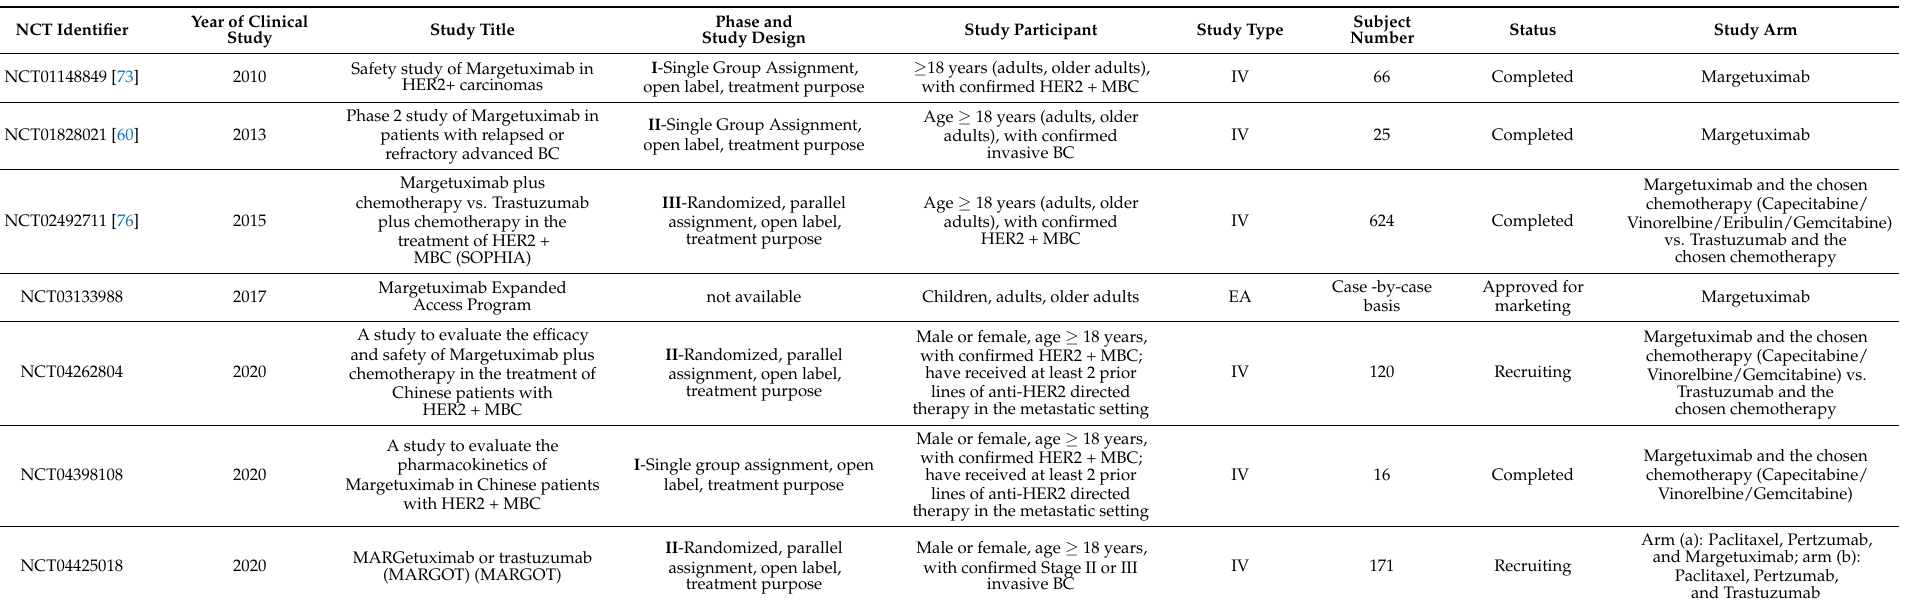
Table 2. Clinical trials involving Margetuximab in breast cancer